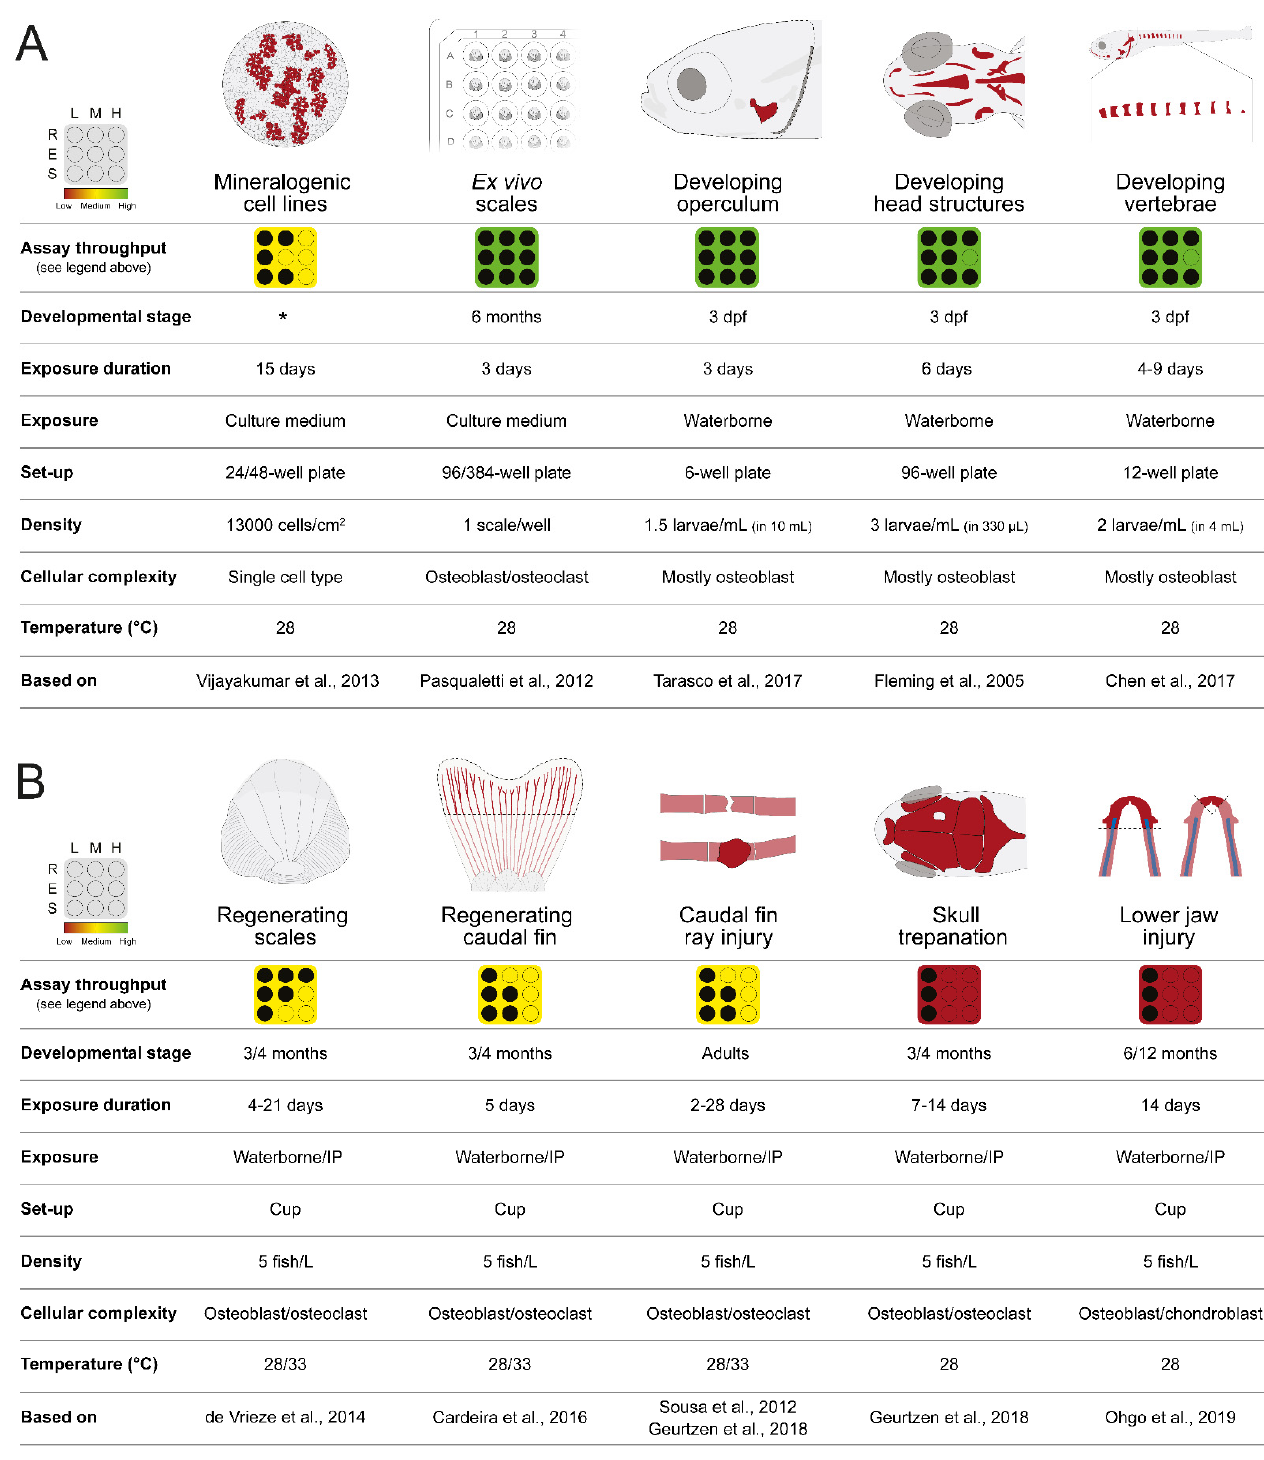
Figure 1. Overview of the zebrafish assays currently available for the screening of osteoactive extracts or compounds. ( A ) Zebrafish models of bone development [22,23,30,42,51]. ( B ) Zebrafish models of bone repair and regeneration. R, number of experimental units; E, exposure duration; S, set-up; L, low; M, medium; H, high; dpf, days post-fertilization; IP, intraperitoneal injection; * Cell line developed from a mixture of calcified tissues from juvenile zebrafish and composed of osteoprogenitor cells